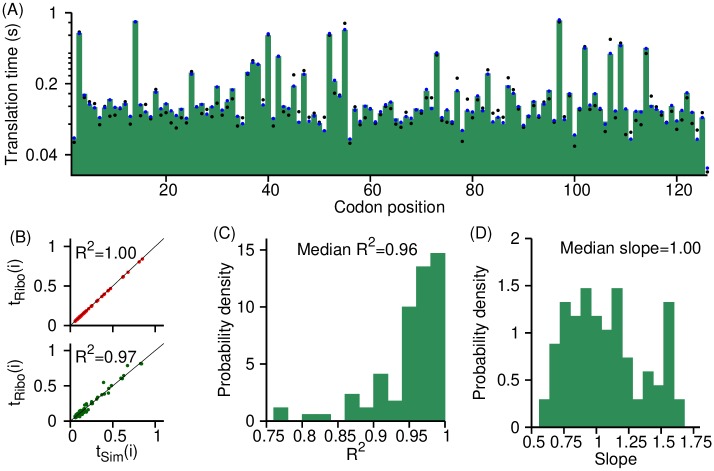
Eq (12) accurately determines codon translation times from simulated ribosome profiles.(A) Average translation time of a codon in YER009W S. cerevisiae transcript is plotted as a function of its position within the transcript. The true codon translation times in the simulations are plotted as green boxes, blue and black data points are the translation times measured using Eq (12). Blue data points were calculated using the average protein synthesis time measured from the simulations and relative ribosome density calculated using a large number of in silico ribosome profiling reads. Black data points were calculated using the average protein synthesis time estimated from the scaling relationship (Eq. (S10)) and the relative ribosome density calculated from the in silico reads which were equal to the reads aligned to the same transcript in the experiment [16]. (B) Measured codon translation times, plotted with black and blue data points in (A), are plotted against true codon translation times in the simulations in the top and bottom panel, respectively. (C) Probability distribution of the R2 correlation between the true and calculated codon translation times for the 85 S. cerevisiae transcripts. (D) Probability distribution of the slope of the best-fit lines between the estimated and true codon translation times for the 85 S. cerevisiae transcripts. The high R2 in (C) and median slope of 1.00 in (D) indicate that Eq (12) can, in principle, accurately measure absolute rates.